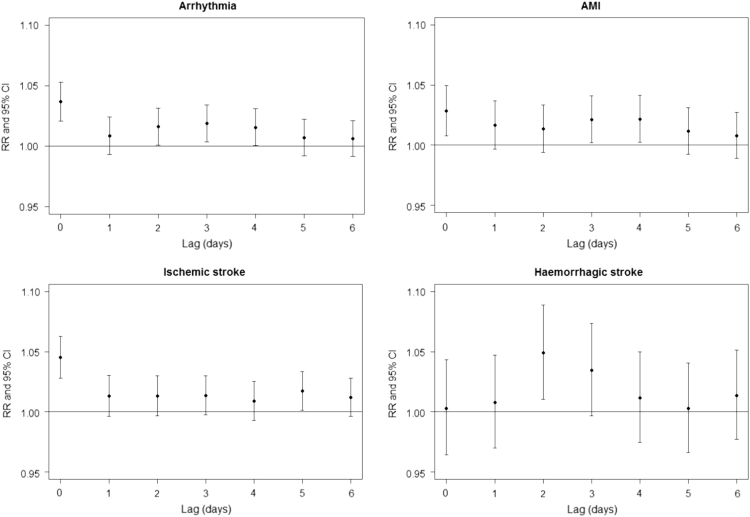
Relative risks (RR with 95% confidence intervals) for the association between NO2 and different cardiovascular diseases per 10 µg/m3 increase of NO2 concentration obtained with the single lag model. Analysis performed for all age groups.